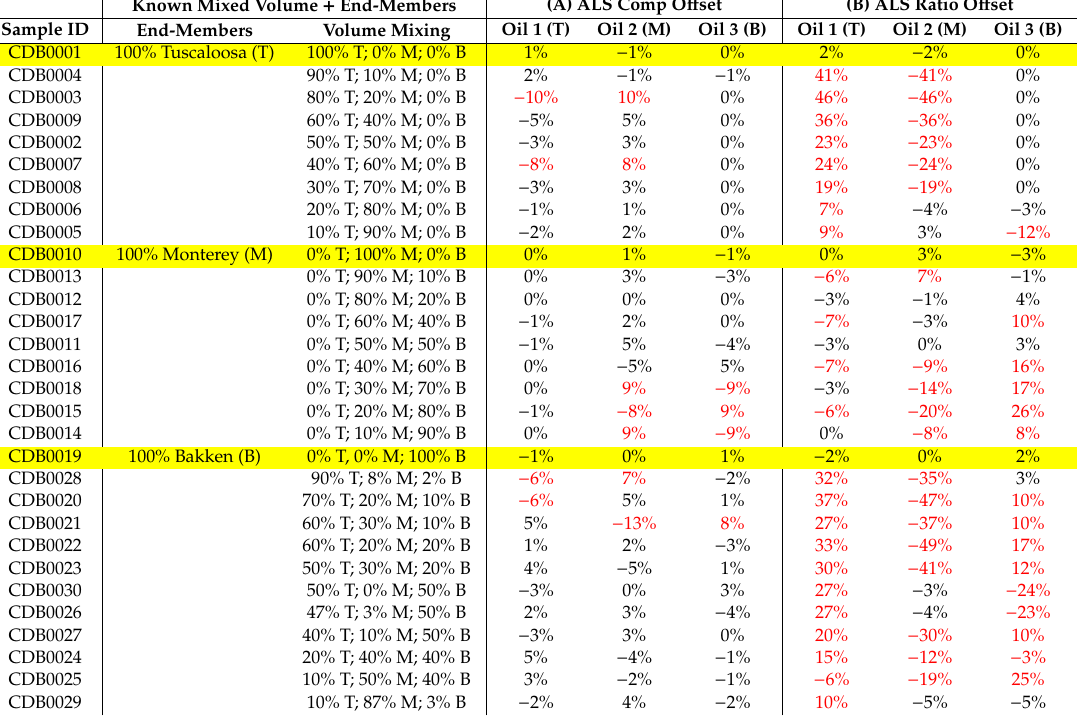
Table 1. Comparison table of the calculated source contributions relative to the known contributions for both the primarily compositional loadings ( A ) and the ratio loadings ( B ). The known end-member oils are highlighted in yellow (Tuscaloosa (T), Monterey (M) and Bakken (B)) as are the known mixed contributions by volume. The percentage o ff set from this known value as determined from ALS, for compositional loadings ( A ) and ratios loadings ( B ) are shown. Calculated contributions greater than 5% from the known mixed value are highlighted in red. Compositional loadings included 15 peaks selected from the collected high resolution gas chromatography (HRGC) and gas chromatography mass spectrometry (GC-MS) results as well as Pr / Ph and Whole Oil δ 13 C VPDB . Ratio loadings included 18 GC-MS biomarker and isotope